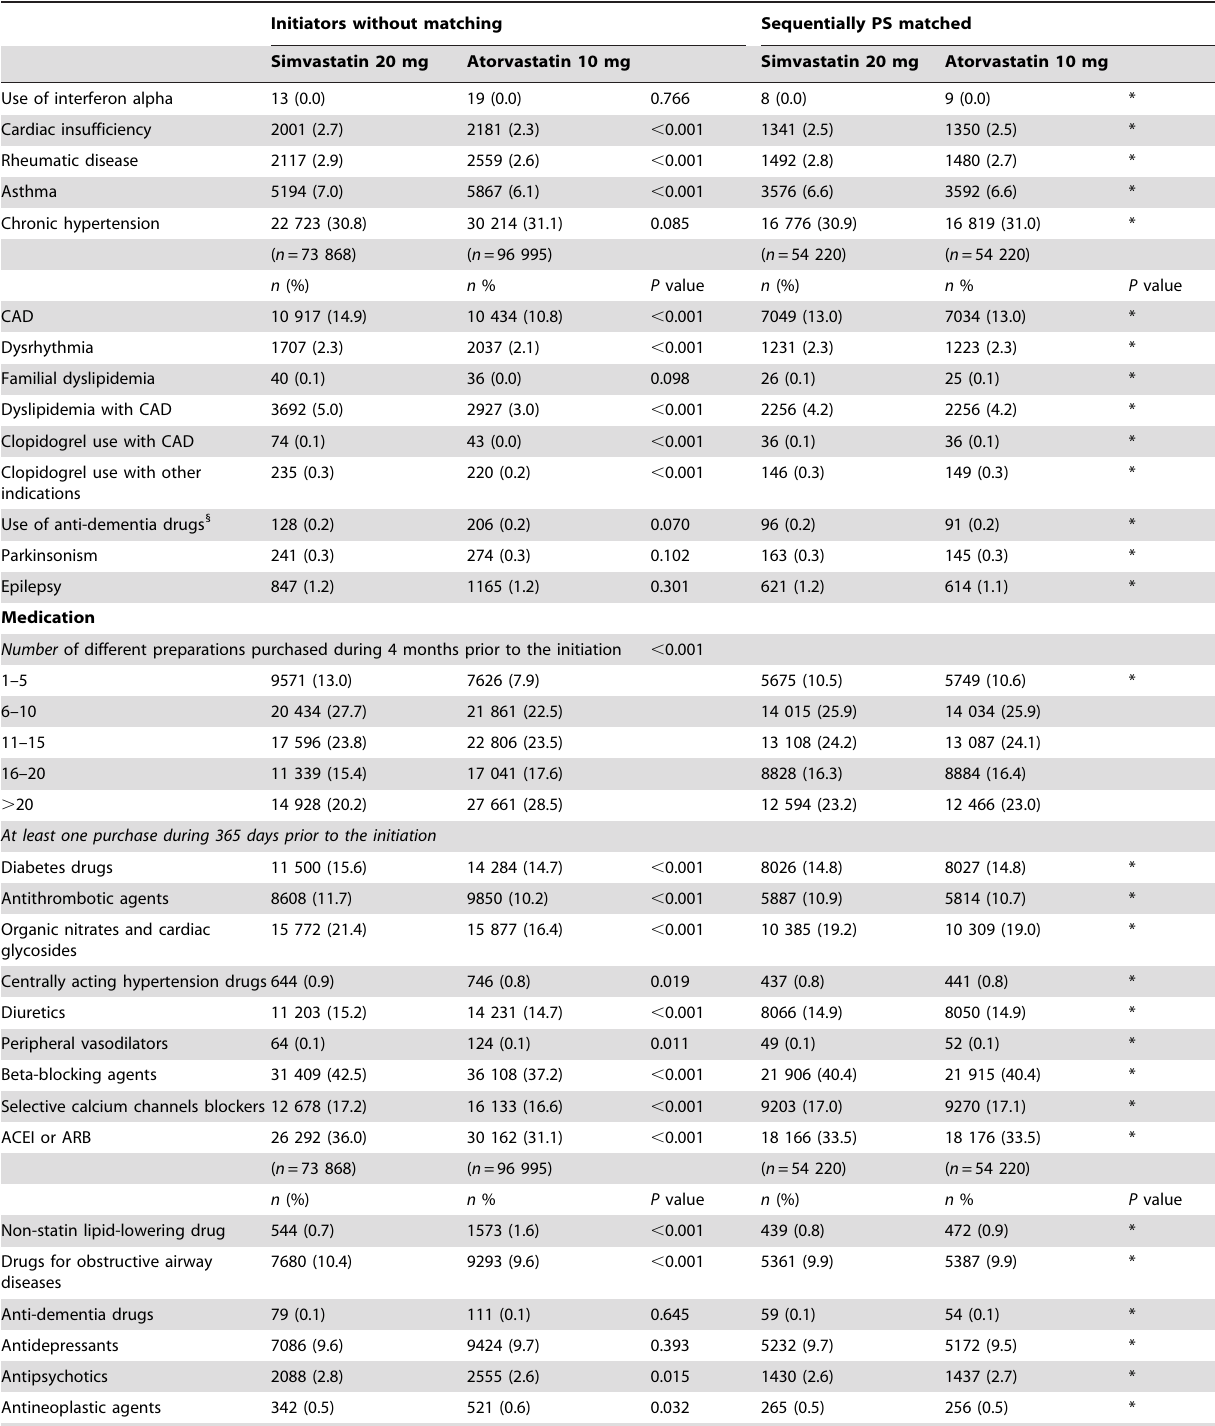
Initiators without